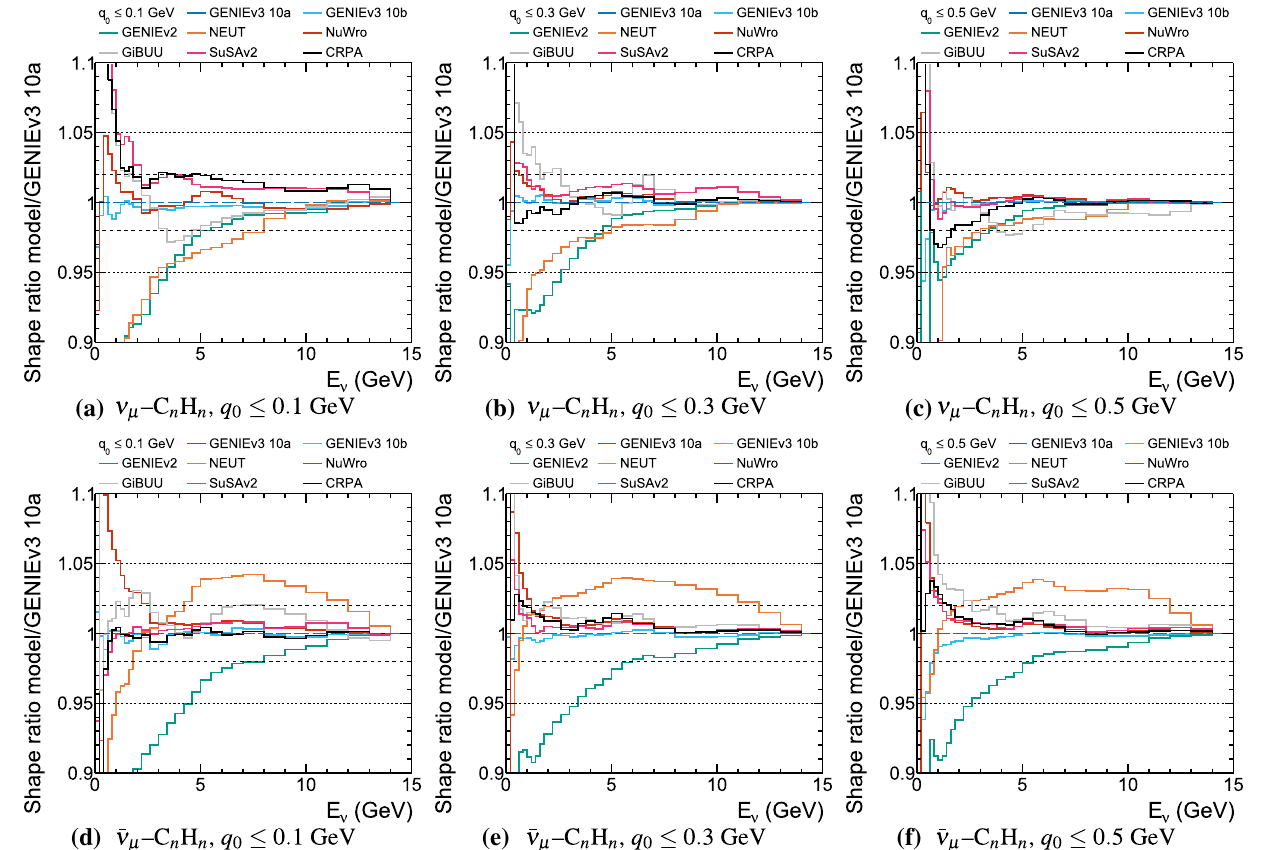
Fig. 12 Comparison of the shape-only ratios of the charged-current cross section with q 0 ≤ 0.1, 0.3 and 0.5 GeV as a function of E true ν , with respect to the GENIEv3 10a prediction. Shown for both ν μ –C n H n